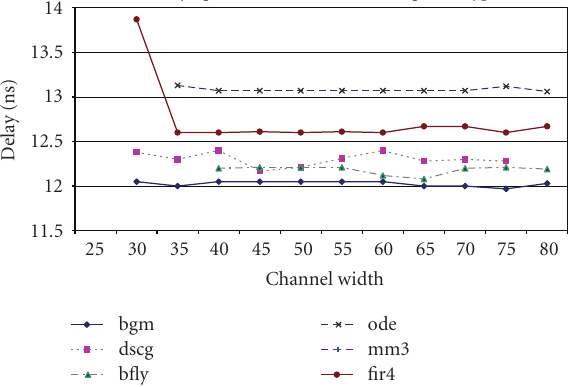
Figure 9: Delay against channel width for single EB-type FPGA.